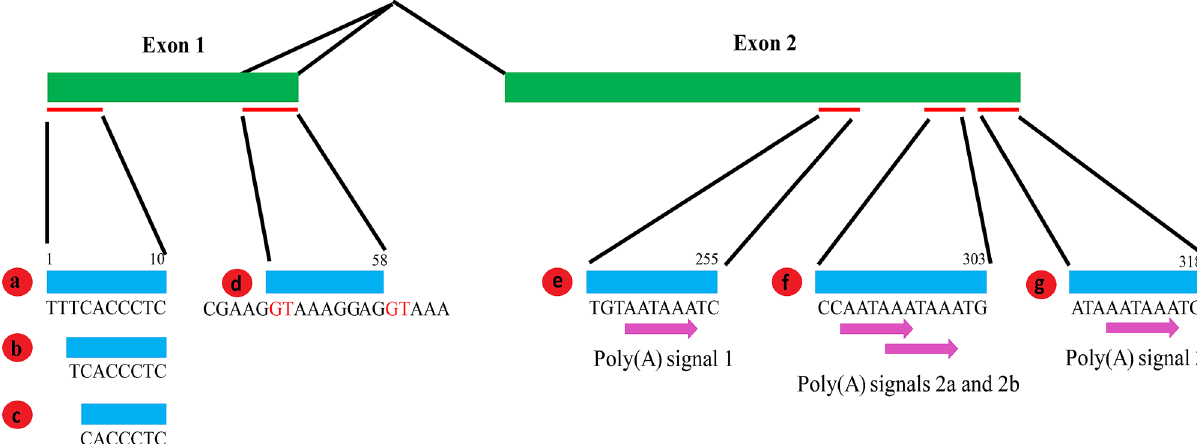
Figure 2. Processing of the mmu-miR-302 host transcript. The numbering is based on the longest variant of the transcript. ( a – c ) Transcription start sites. ( d ) Alternative splicing, splice donors shown in red. ( e , f , g ) Different 3 ′ terminations. The corresponding sequnces were deposited to GenBank with accession numbers: a: KT932380;